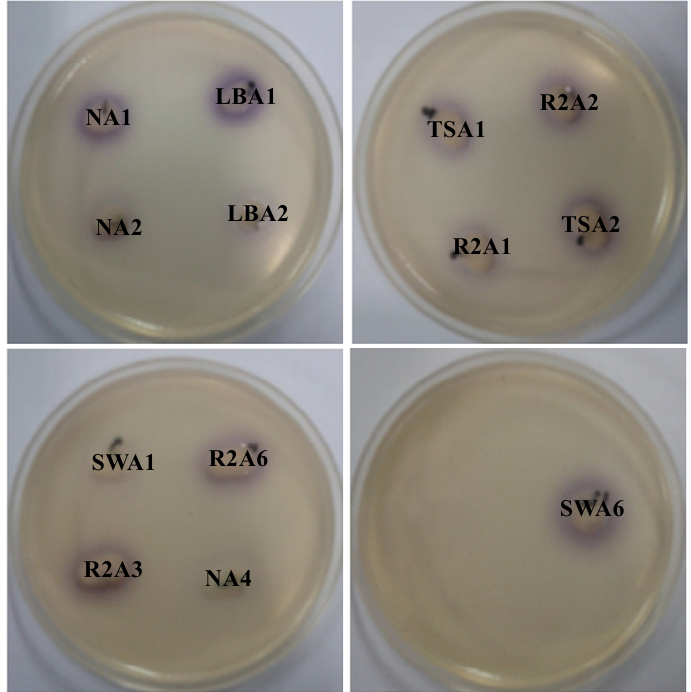
Figure 1. Screening of bacterial isolates for AHLs production using agar-plate well diffusion assay with C. violaceum CV026. All the thirteen isolates producing short and medium-chain AHLs are shown.